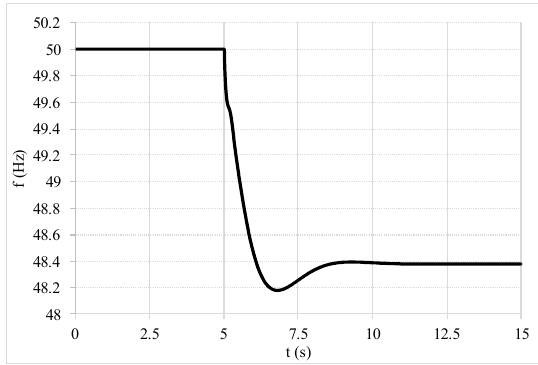
Figure 9. Overall active power characteristics of the test network.